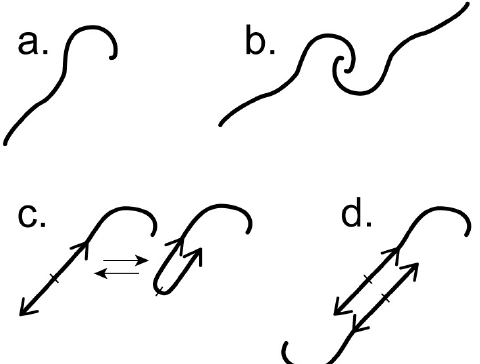
molecules. ( a, b ) Earliest monomer and dimer; ( c, d ) Monomer and dimer of molecules with partial palindromic